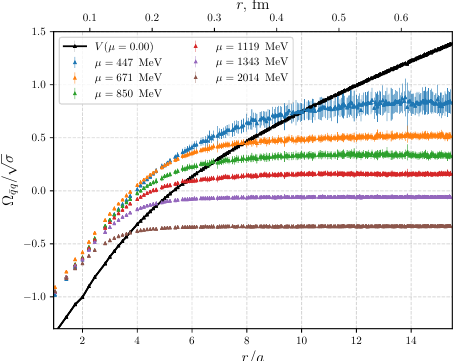
Figure 3 . The (cid:10) (cid:22) qq as a function of distance for few values of the chemical potential under study. The black curve is the potential of the static quark-antiquark pair at zero density and tempera- ture.Note the absence of a Coulombic small distance regime, due to